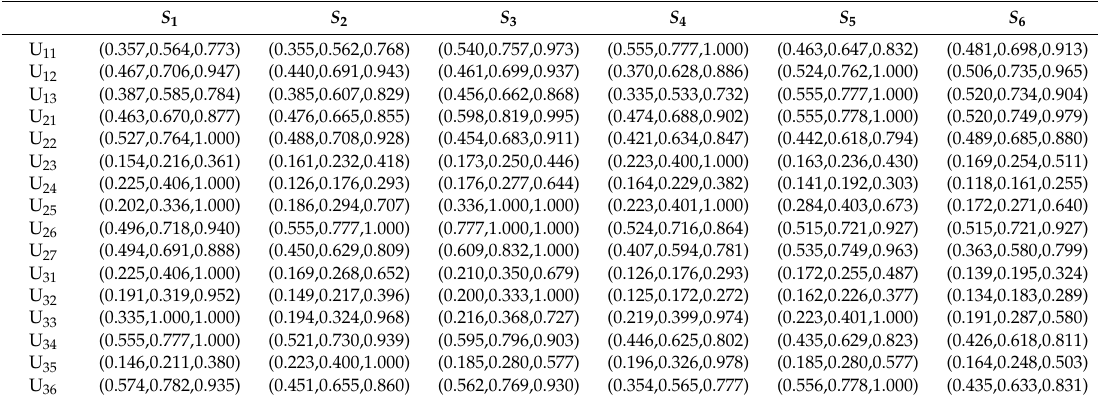
Table A2. The normalized fuzzy decision matrix.